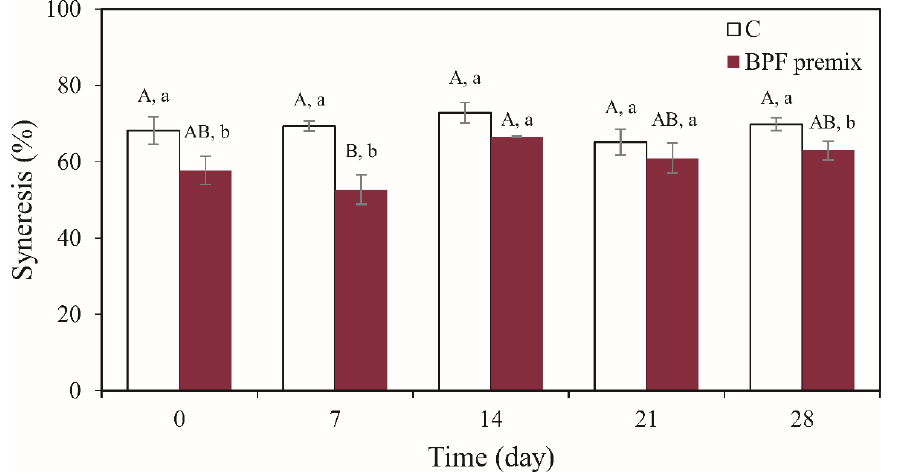
Figure 3. Amount of whey segregated (%) from yogurt prepared by applying neat (control (C)) starter cultures and the 3% BPF premix. Values are presented as mean ± standard error ( n = 3); AB a significant difference in means during time within the same sample, ab a significant difference of means between samples at the same time according to the HSD test ( p < 0.05).